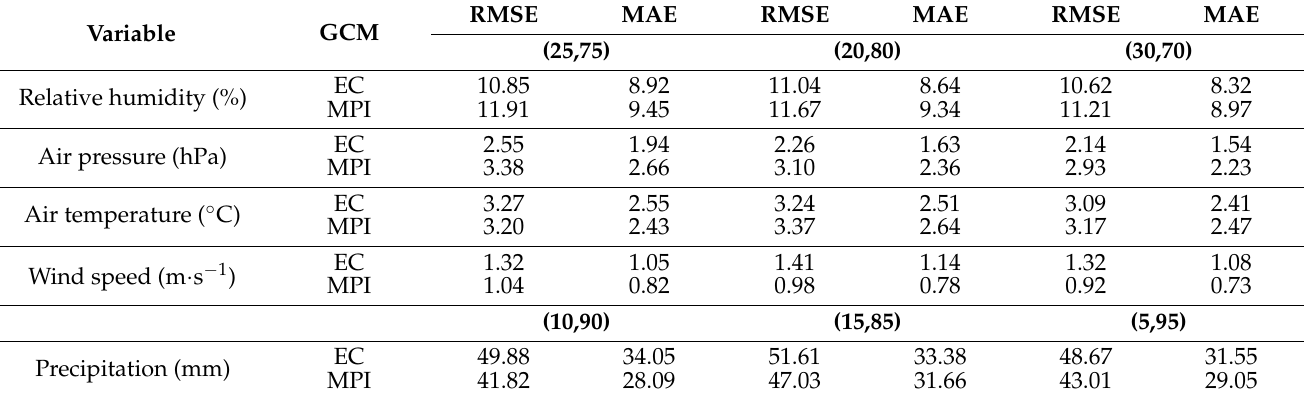
Table A3. RMSE and MAE values measured at Wushaoling between the calibrated results and the monthly observations in the 1985–1999 period using different pairs of quantiles: (25,75), (20,80), (30,70), except for precipitation where (10,90), (15,85) and (5,95) were compared. Same as Table A2 but at